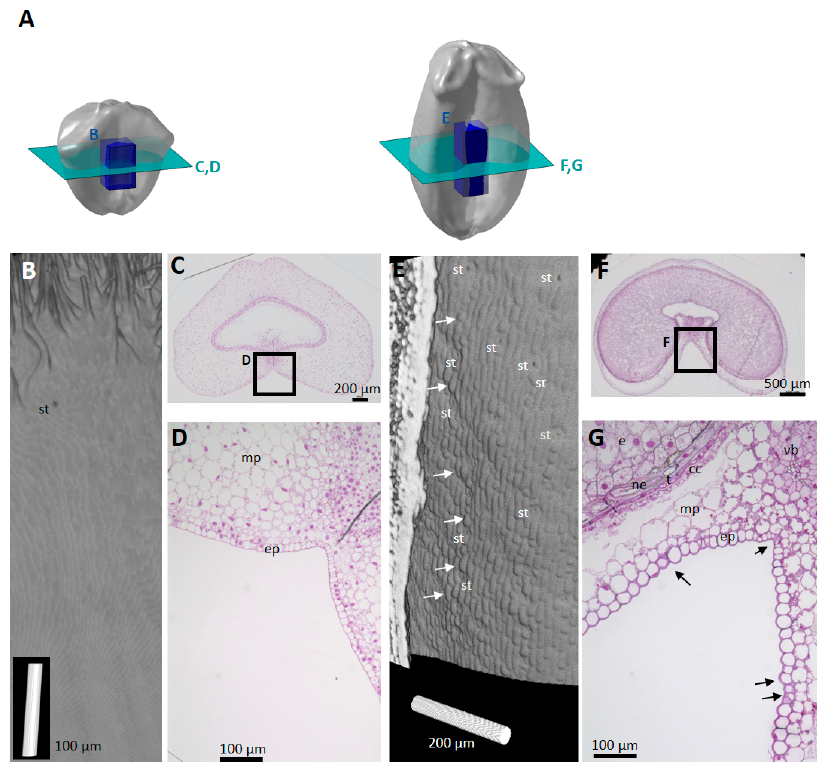
Figure 6. Variability in epicarp cell shape. ( A ) Localization of the regions observed. Light blue planes correspond to approximate positions of microscopy sections shown in ( C , D , F , G ). Dark blue boxes correspond to the position of 3D reconstructions. ( B , E ) A 2D projection of a 3D visualization of epi- carp cell surface from X-ray µCT, ventral side, 50 °DAA ( B ) 250 °DAA ( E ). Cell borders are visible at 250 °DAA not at 50 °DAA. ( C , D ) Light micrographs of a wheat caryopsis harvested at 50 °DAA. ( C ) Entire cross-section stained with toluidine blue, and ( D ) zoom on the epicarp cells in the ventral region. ( F , G ) Light micrographs of a wheat caryopsis harvested at 250 °DAA. ( F ) Entire cross-section stained with toluidine blue, and ( G ) zoom on the epicarp cells in the ventral region. The arrows point at different cell shape and size. Legend: mp—mesocarp; cc—cross cells; tc—tube cells; ep— epicarp; vb—vascular bundle; e—endosperm; ne—nucellar epidermis; st—stomata; t—testa. 2.4. Porosity and Cell Orientation of Mesocarp The mesocarp tissue contains parenchyma cells. As shown in Figures 1–4, the meso- carp tissue contained large voids surrounding the seed due to programmed cell death, and smaller voids between mesocarp cells. X-ray image observation suggested a variabil- ity in the proportion of intercellular voids depending on the position within the caryopsis (Figure 1). In particular, we observed intercellular voids at the top of the grain (Figure 1) and in the ventral side of the caryopses below the epicarp (Figures 4 and 5). This region was investigated using 3D visualizations (Figure 7A). This highlighted the connections between these empty spaces between ventral mesocarp cells (Figure 7B).